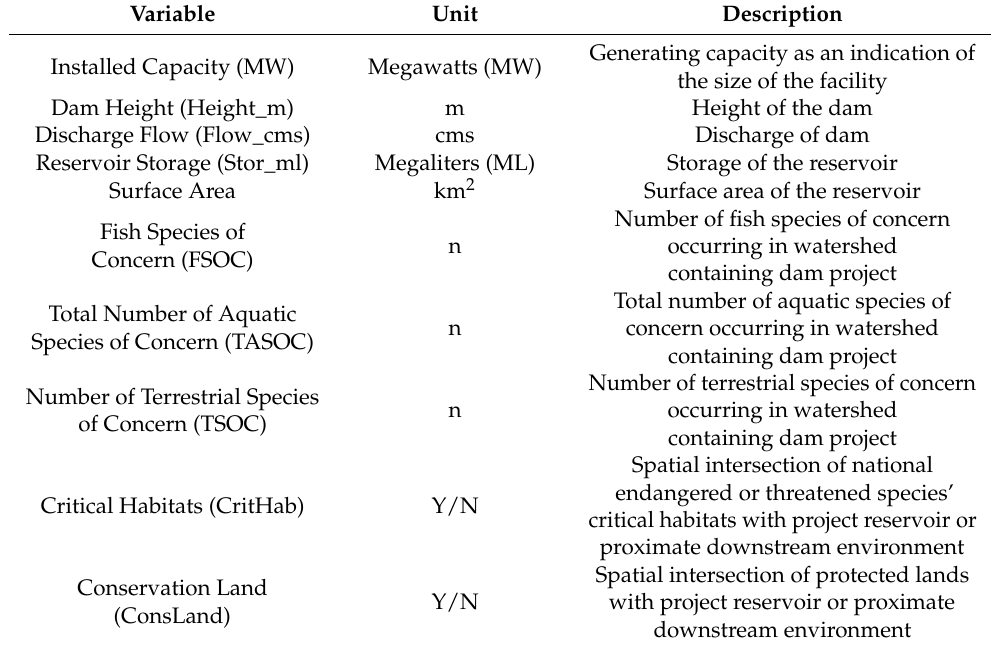
Table 3. Indicators of dam attributes as input vector of DMU and predictive variables used in developing the environmental envelope model (EEM), their description.